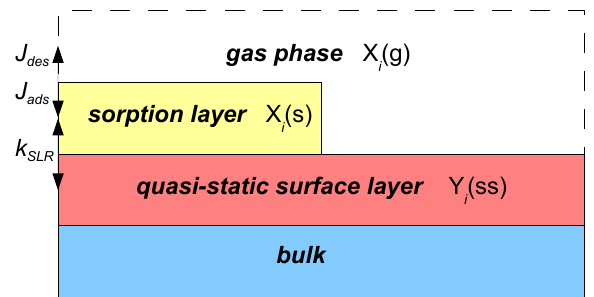
Fig. 1. The applied surface layer model is shown as a schematic. The gas-particle interface is divided into a gas-phase (g) with gas-phase species X i (g), a sorption layer (s) with adsorbed gas-phase species X i (s), a quasi-static surface layer (ss) with non-volatile particle components Y i (ss), and a particle bulk. The adsorption and desorption fluxes are indicated as J ads and J des , respectively, and the rate coefficient for surface layer reactions is denoted by k SLR . Adapted from P¨oschl et al. (2007).